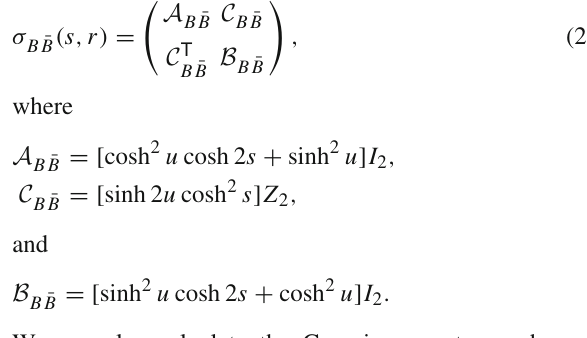
contour diagram of Gaussian quantum coherence between Alice and anti-Bob versus the squeezing parameter s and the ratio D / M . The frequency of the scalar field is fixed as ω =